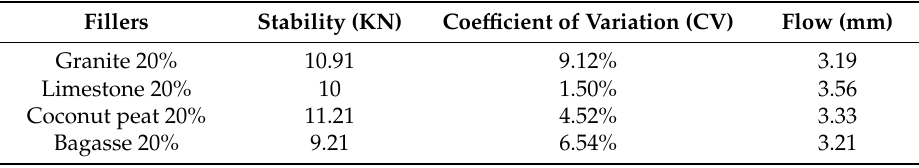
Table 8. Result of Marshall stability and flow test (considered mastic